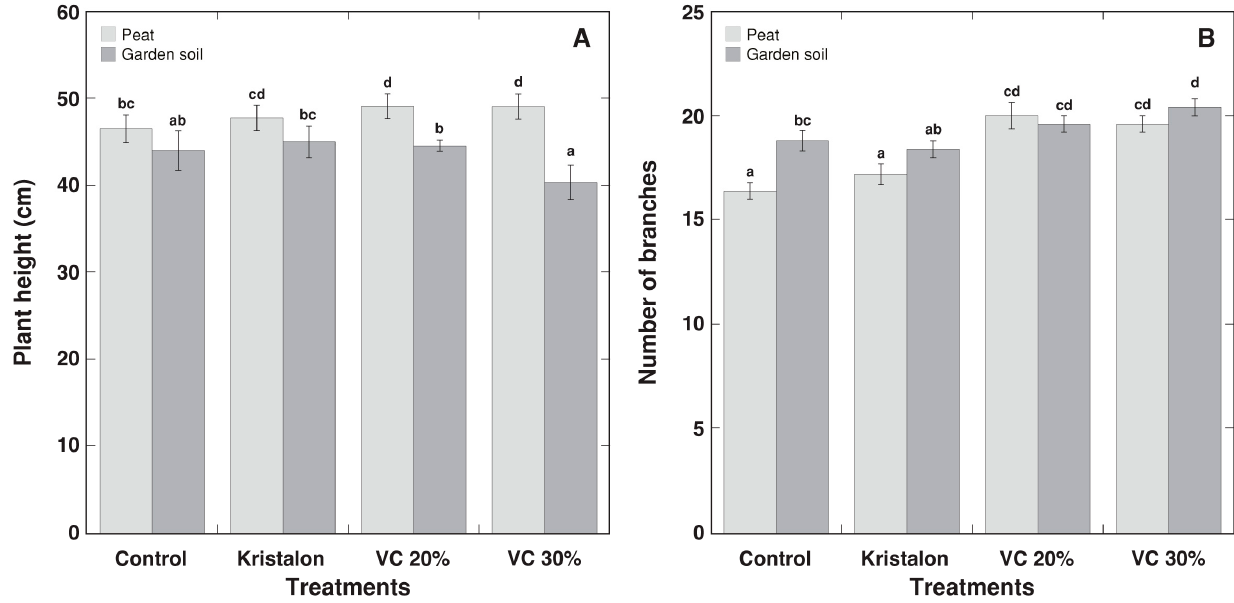
Figure 7. Effect of mineral fertilizer (Kristalon) and amendment with vermicompost (VC) at a 20% and 30% ( v / v ) rate on plant height ( A ) and number of branches ( B ) of Dracocephalum moldavica plants grown in peat substrate or commercial garden soil for 8 weeks. Results are means ± SE from five replicates for each treatment. Means with identical letters are not considered statistically significantly different ( p < 0.05).